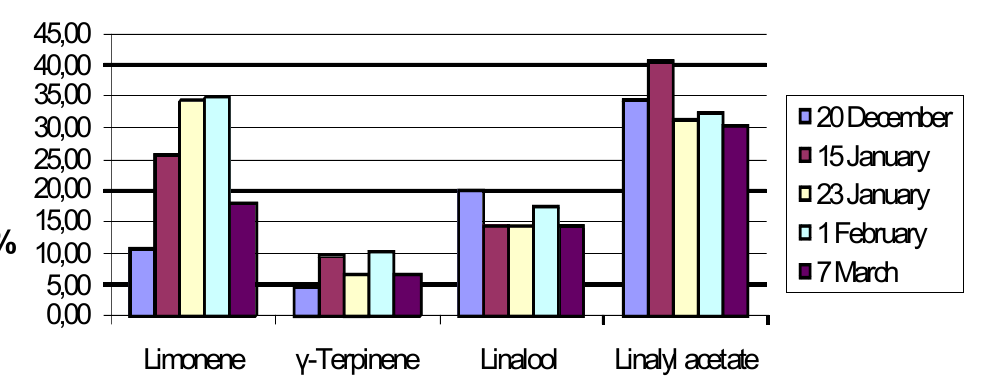
Figure 1 . Variation of the main components concentration depending on harvesting